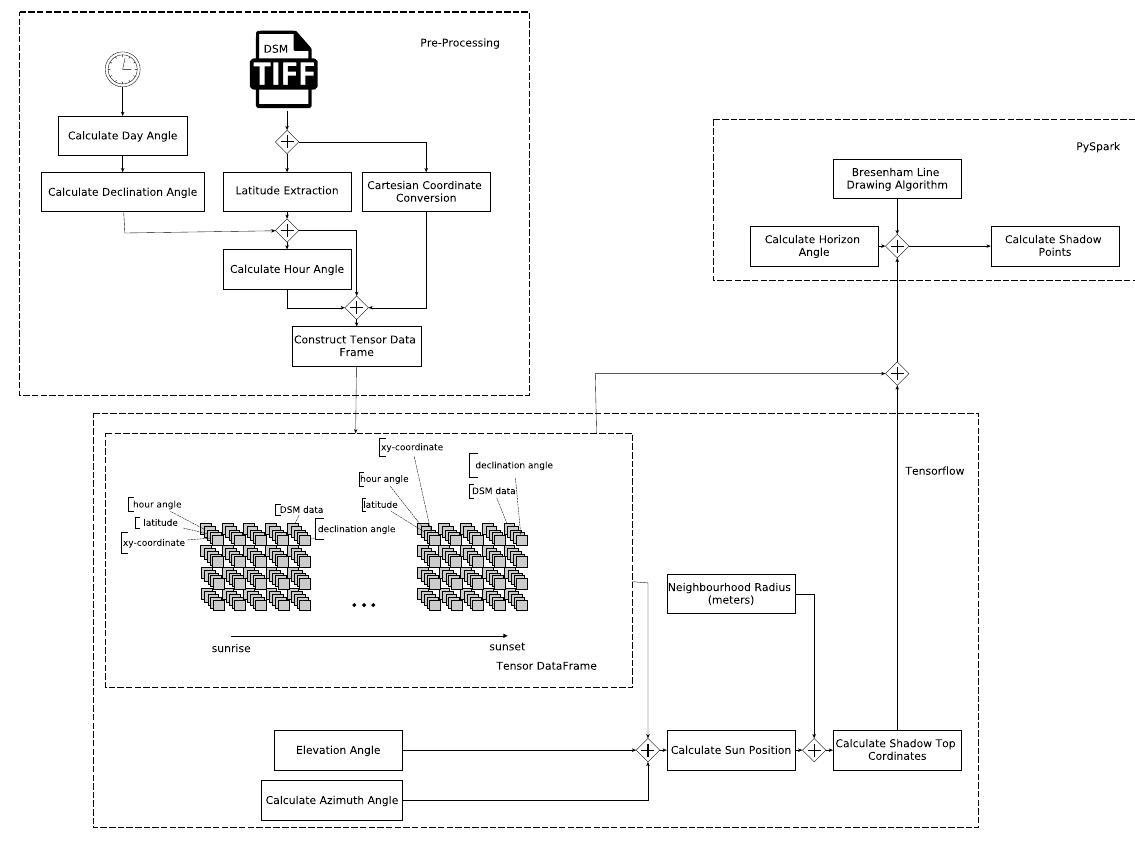
Figure 5. Block Diagram of Shadow Calculation